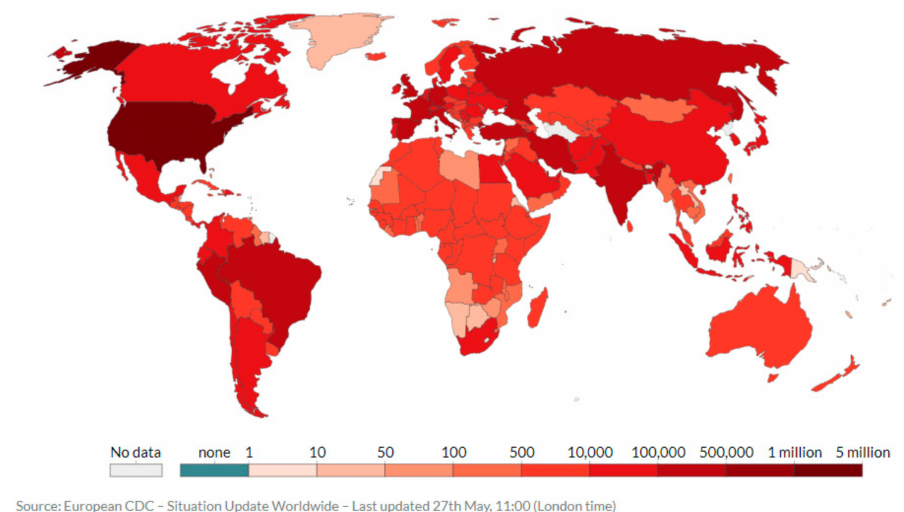
Figure 1. Total worldwide deaths due to COVID-19 per million people (as on May 27, 2020) [4].